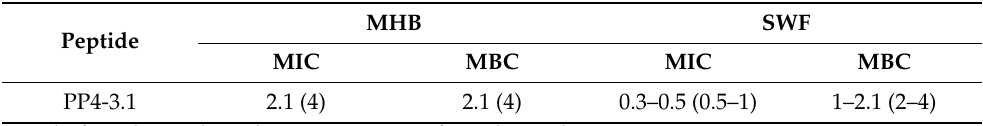
Table 6. MIC and MBC values in µ M ( µ g/mL) of PP4-3.1 against S. aureus (ATCC 29213) in MHB and SWF a . MHB SWF Peptide MIC MBC MIC MBC